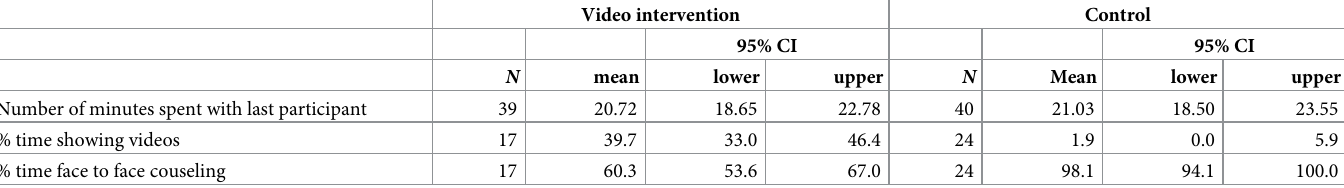
Video intervention Control 95%